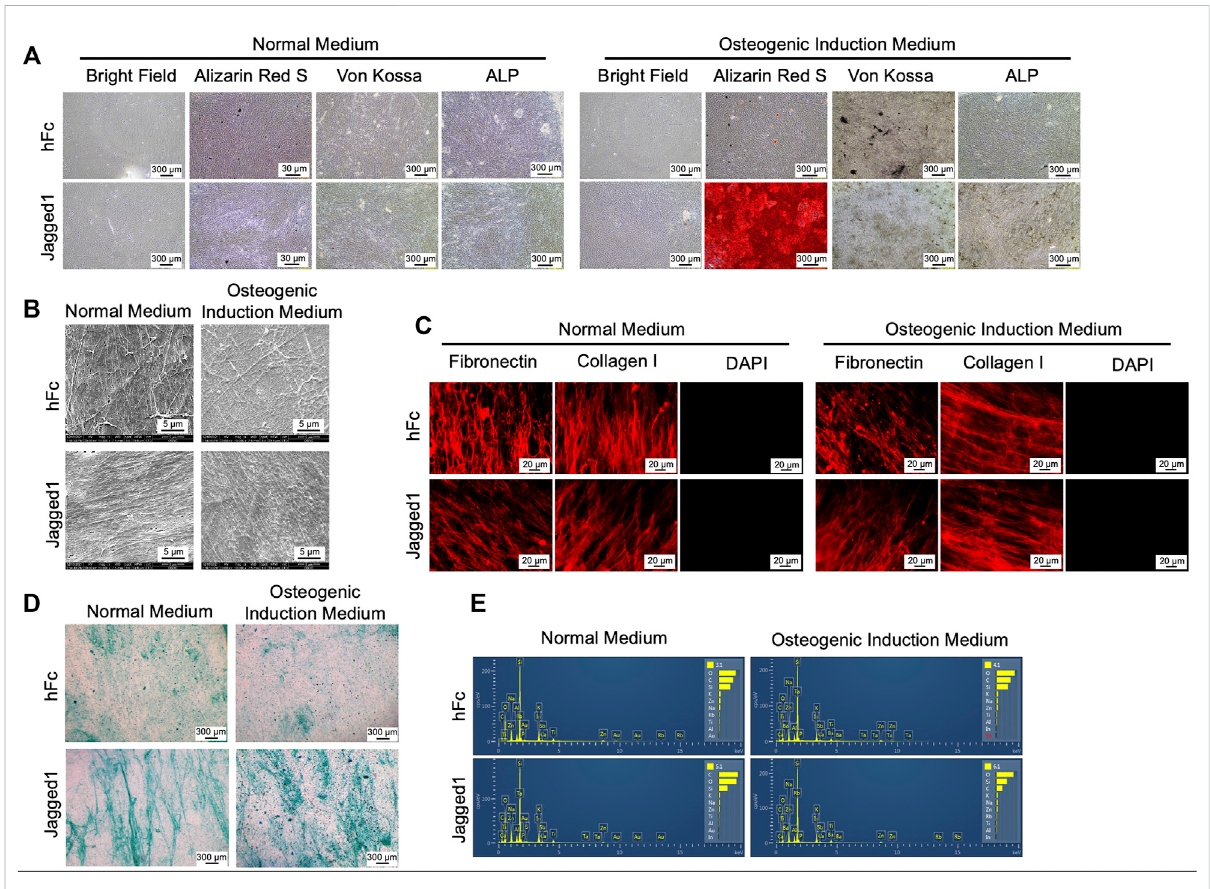
FIGURE 2 Characterization of decellularized extracellular matrix (dECM). Morphology, mineralization, and alkaline phosphatase enzymatic activity (ALP) were examined (A) . Ultrastructure of dECM was observed using scanning electron microscopic analysis (B) . Fibronectin and type I-collagen were determined using immuno fl uorescence staining (C) . The genetic component was stained using DAPI (C) . Glycosaminoglycans deposition was detected by Alcian Blue staining (D) Chemical composition of dECM was examined using energy-dispersive X-ray spectrometry (E) . dECM-N; decellularized extracellular matrix derived from maintaining cells in normal medium, dECM-OM; decellularized extracellular matrix derived from maintaining cells in osteogenic